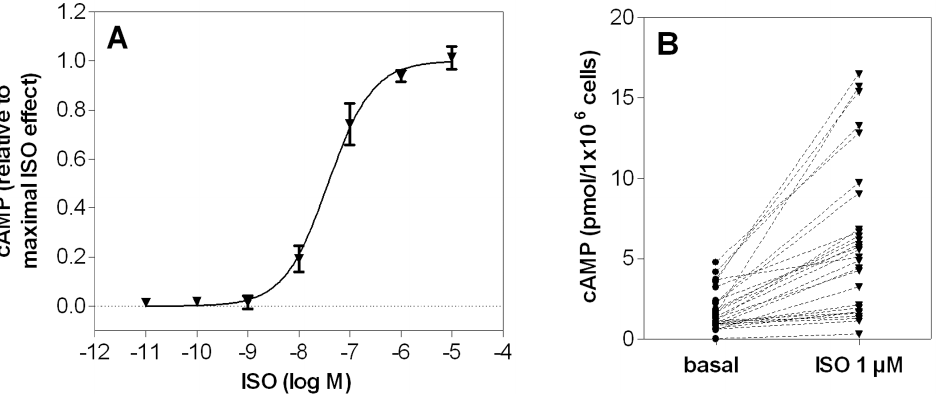
Figure 2. Measurement of cAMP content in neutrophil granulocytes (cAMP assay). cAMP accumulation in human neutrophil granulocytes (5 6 10 5 cells per sample) was monitored by HPLC-MS/MS system as described under Materials and Methods . ( A ) Concentration-response curve for ISO in the cAMP assay. Data shown are from four independent experiments, performed in triplicate (data points are mean 6 S.E.M.). The maximal ISO- induced cAMP production was set to 1.00. Data were analyzed by non-linear regression and were best fitted to sigmoidal concentration/response curve. (B ) Inter-experimental variability of basal cAMP concentration in neutrophil granulocytes (basal) and cAMP level after stimulation with 1 m M ISO (ISO 1 m M). Each data point represents one independent experiment. cAMP levels after stimulation with ISO increased by 30–1000% relative to basal cAMP levels.